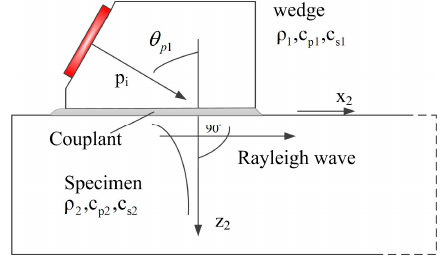
Figure 2. Generation of Rayleigh wave by an angle beam wedge transducer in the x-z plane.